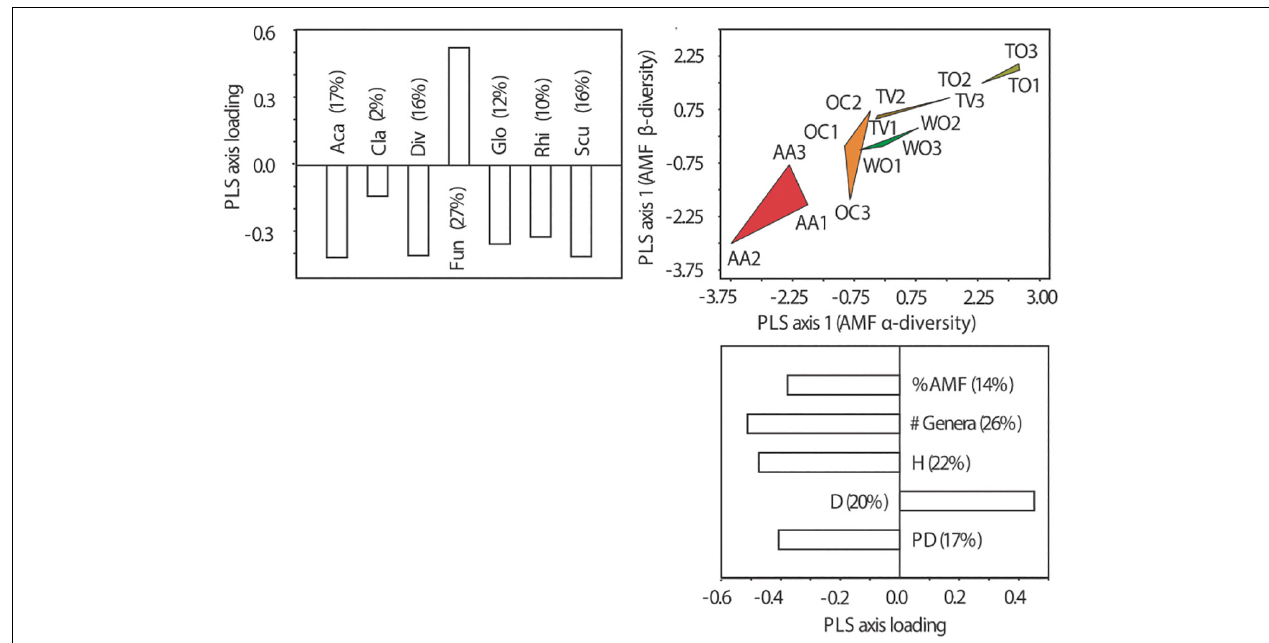
FIGURE 5 | Partial least square (PLS) ordination plots separating five land-use types along the first ordination axes of α - and β -diversity of arbuscular mycorrhizal fungal (AMF) communities at the genus level. Three fields on different farms were analyzed per land-use type. The magnitude of influence (PLS axis loading) of the explanatory variables is indicated in the form of bar plots next to the ordination axes. The percentage contribution of the individual variables to the variance resolved by the respective ordination axis is indicated in brackets. See Figure 1 for land-use abbreviations. The AMF genera were: Aca , Acaulospora Gerd. and Trappe; Cla , Claroideoglomus C. Walker and A. Schüßler; Div , Diversispora C. Walker and A. Schüßler; Fun , Funneliformis C. Walker and A. Schüßler; Glo , Glomus Tul. and C. Tul.; Rhi , Rhizophagus P.A. Dang; Scut , Scutellospora C. Walker and F.E. Sanders. #AMF, number of AMF genera; %AMF, percentage of root colonization by AMF; D, dominance of AMF at the genus level; H, Shannon diversity of AMF at the genus level; PD, phylogenetic diversity of